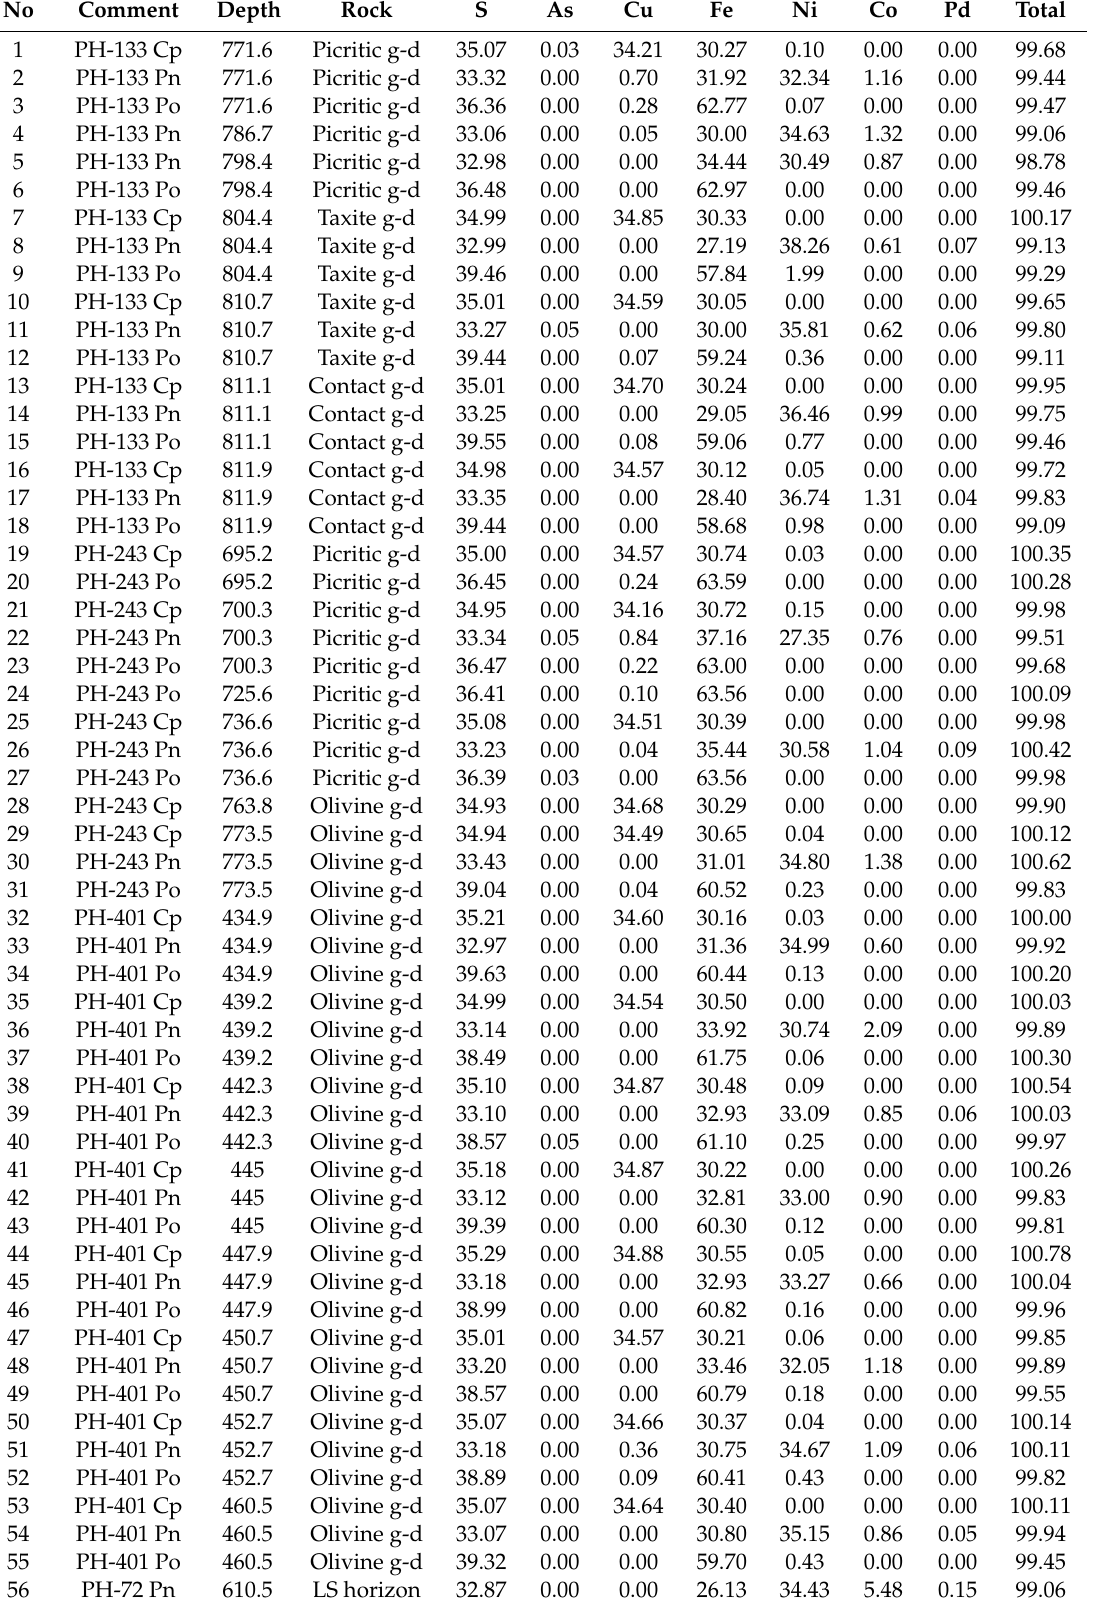
Table 3. Sulfide compositions in the Main Ore Horizon of the Norilsk 1